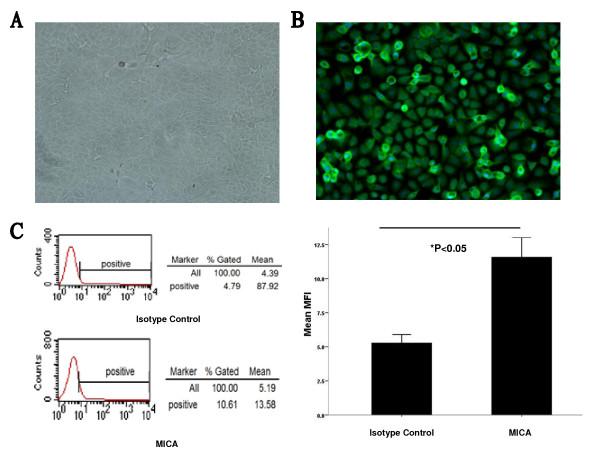
Expression of MICA on human corneal epithelium in vitro.
(A) In vitro cultured human corneal epithelium was polygonal or
fibroid in shape. (B) It was immunostained for K3/K12 (green),
followed by Hochest staining (blue). (C) MICA-positive corneal
epithelium was detected (red histogram in left figure) by flow
cytometry. Results obtained from one of three samples are illustrated.
Right figure shows that the MFI of the isotype control was significantly
different from that of MICA.